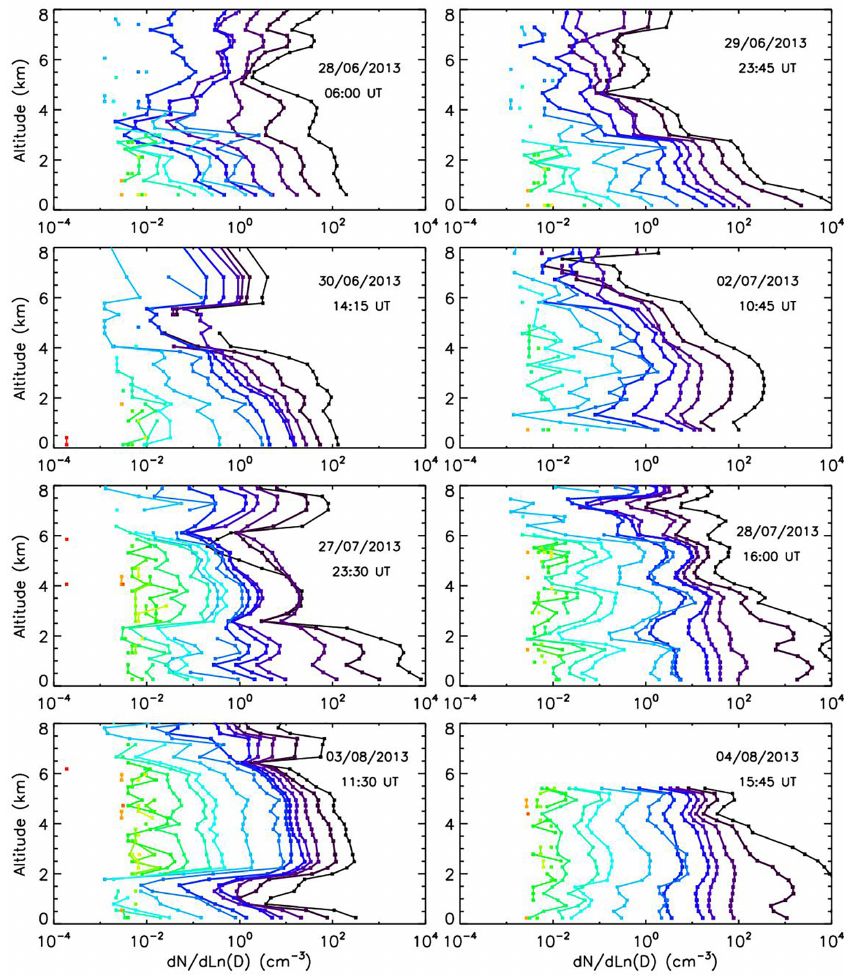
Figure 10. Same as Fig. 7 but for other sand plume events observed over Minorca (27 June–2 July) and Ile du Levant (27 July–4